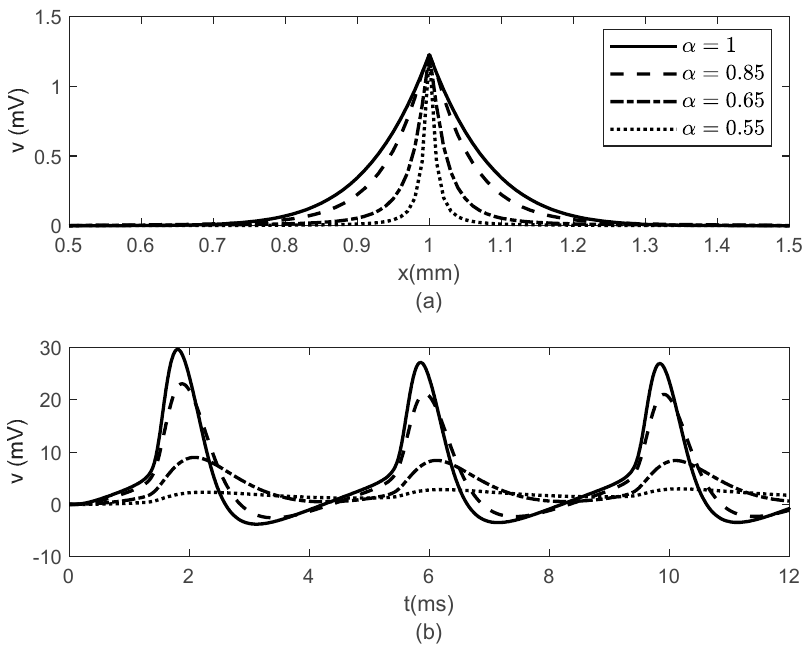
Figure 4. ( a ) Spatial variations of 𝑣(𝑥,𝑡) at 𝑡 = 0.1 ms , and ( b ) temporal variations of 𝑣(𝑥, 𝑡) at 𝑥 = 700 μm for various values of 𝛼 . Here, 𝑝 = 0, 𝑞 = 1, and 𝛽 = 1.